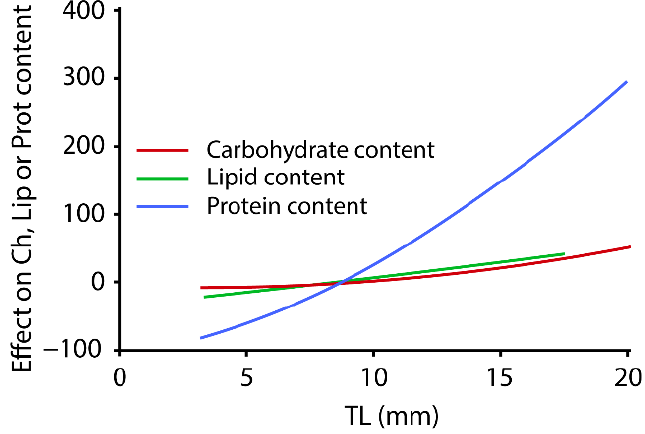
Figure 10. GAM model of organic compounds. Effect of the total length on the protein, carbohydrates and lipid content obtained with the best GAM models, using the interaction size-area as a variable.